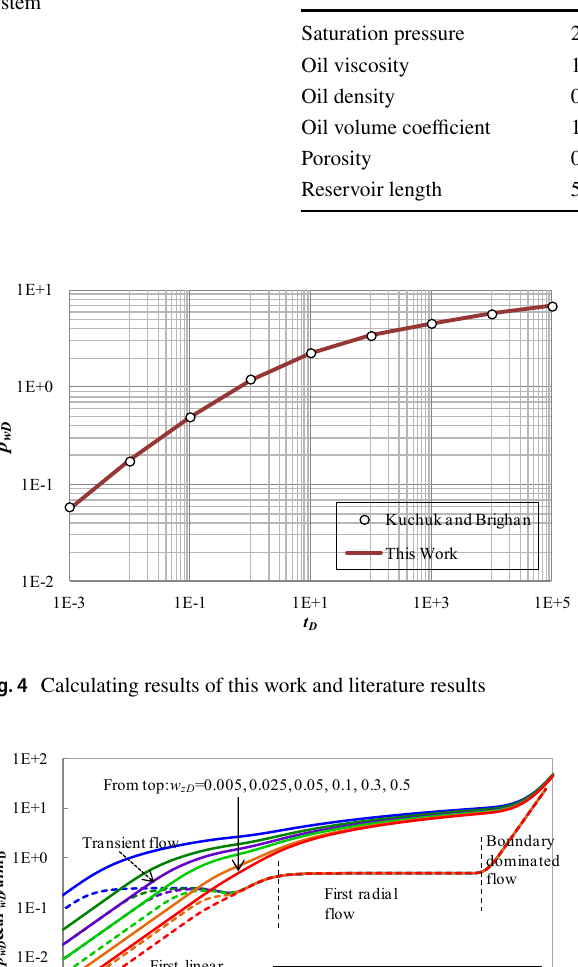
Table 1 Basic data of the system